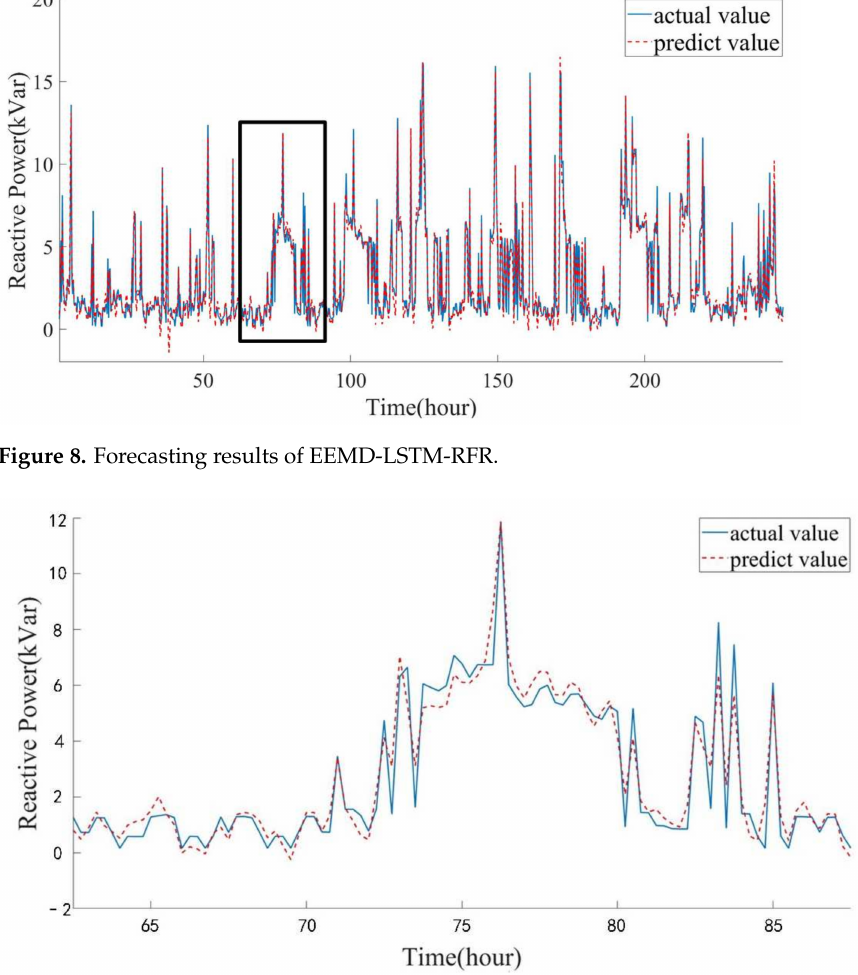
Figure 9. Partial enlarged